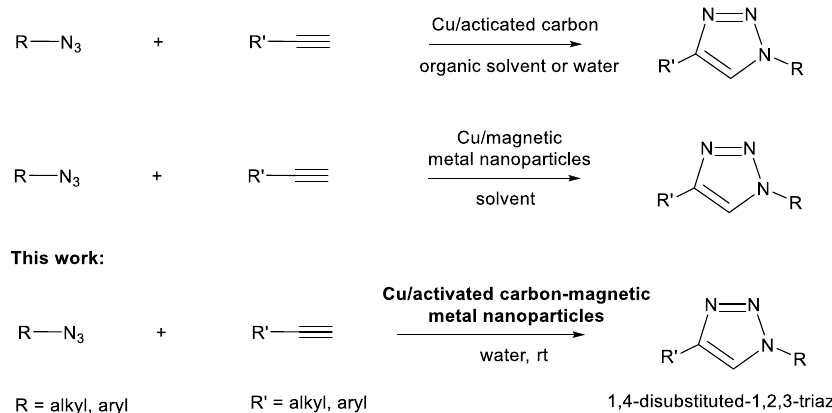
Figure 1. Click CuAAC performed under heterogeneous catalysis.